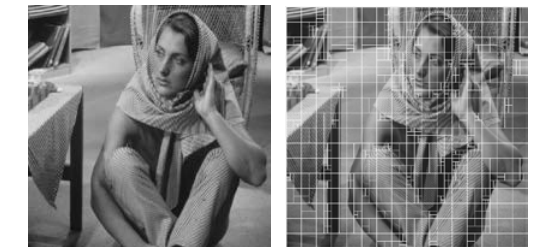
Fig. 2. Calculate the depth map.